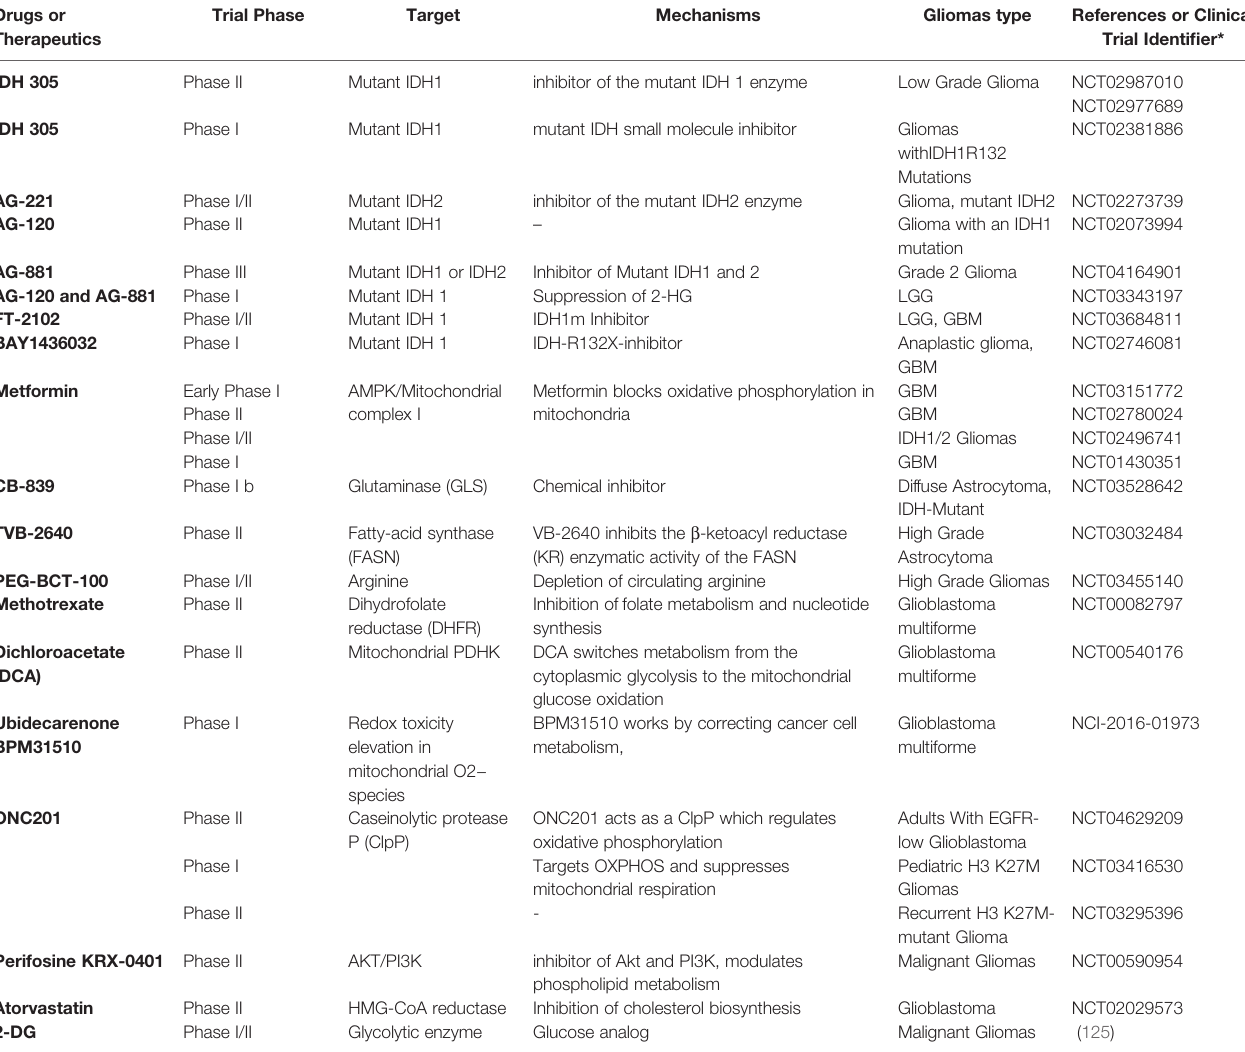
TABLE 1 | Current Advances and main clinical trials in metabolism targeting for gliomas therapy. Drugs or